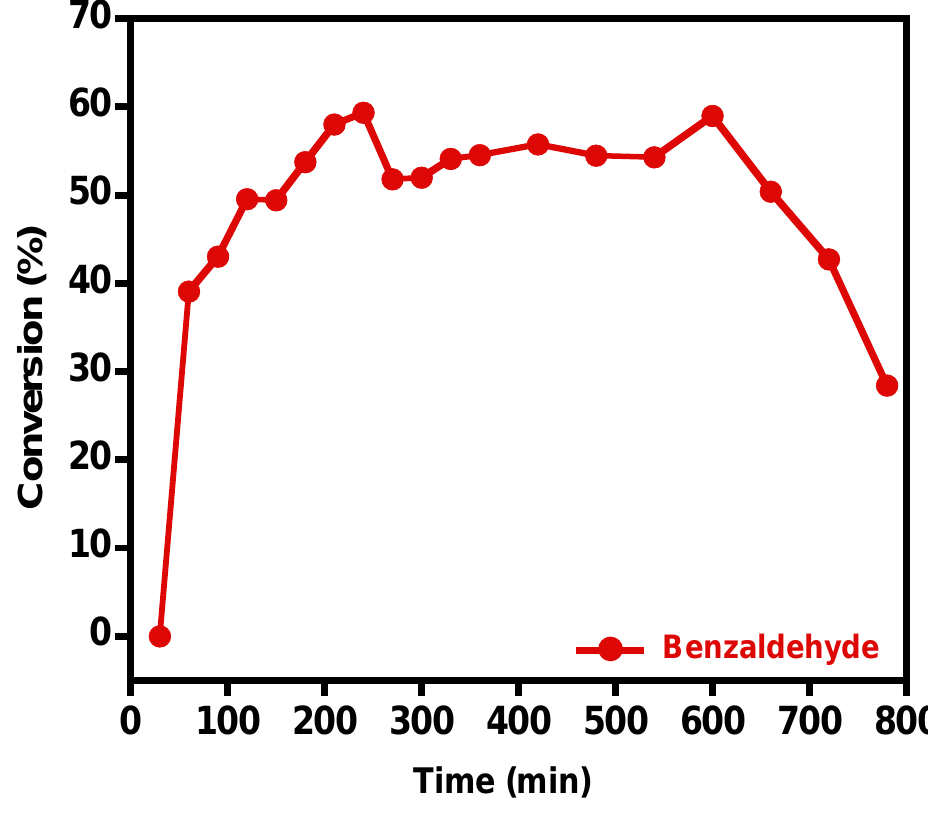
Figure 10. Graphical illustration of the conversion of toluene to benzaldehyde obtained during the catalytic evaluation using Cu x Zn y O (conditions: catalyst amount: 0.3 g; toluene flow: 0.01 mL/min; calcination temperature: 450 ◦ C; reaction temperature: 250 ◦ C). Table 2. Comparison with previously reported catalysts for the oxidation of toluene. Sl.